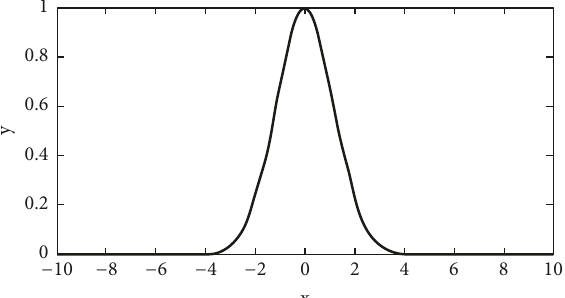
Figure 5: Reward as Gauss type membership function.